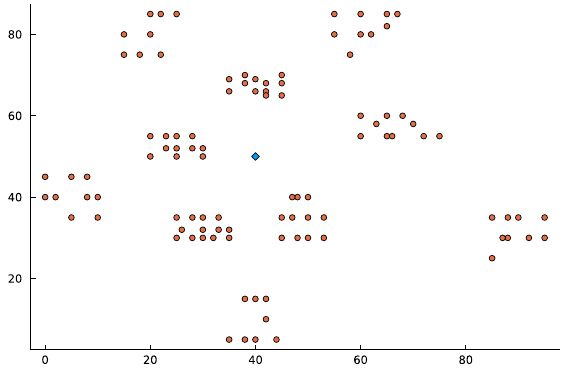
Figure 1. Distribution of customers (represented by circles) in C-instances with diamond representing the center.